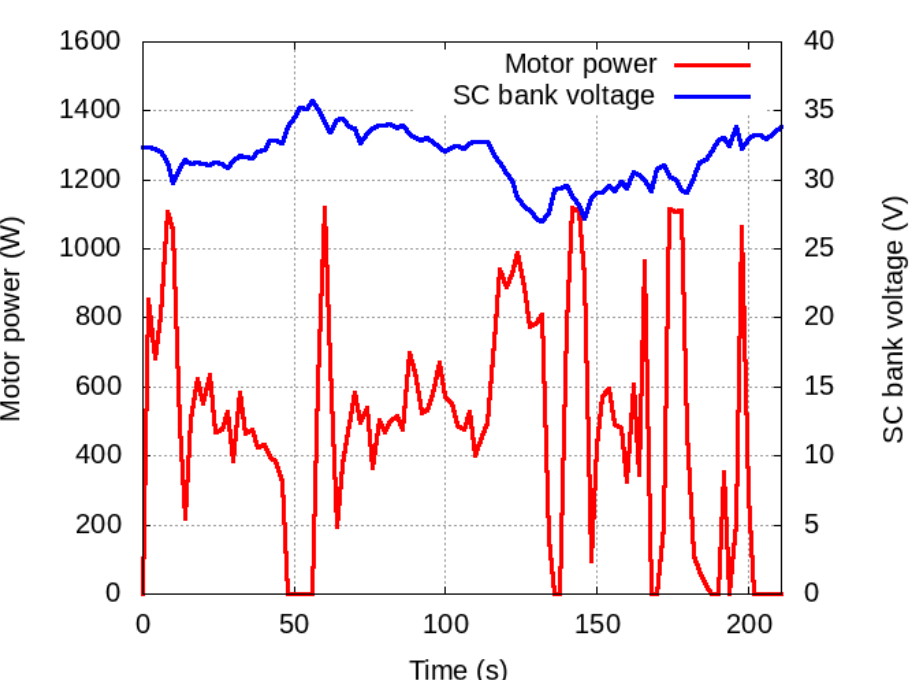
Figure 12. Power and SC voltage diagram, created from data logged during the 3rd lap of the Shell Eco-marathon Europe